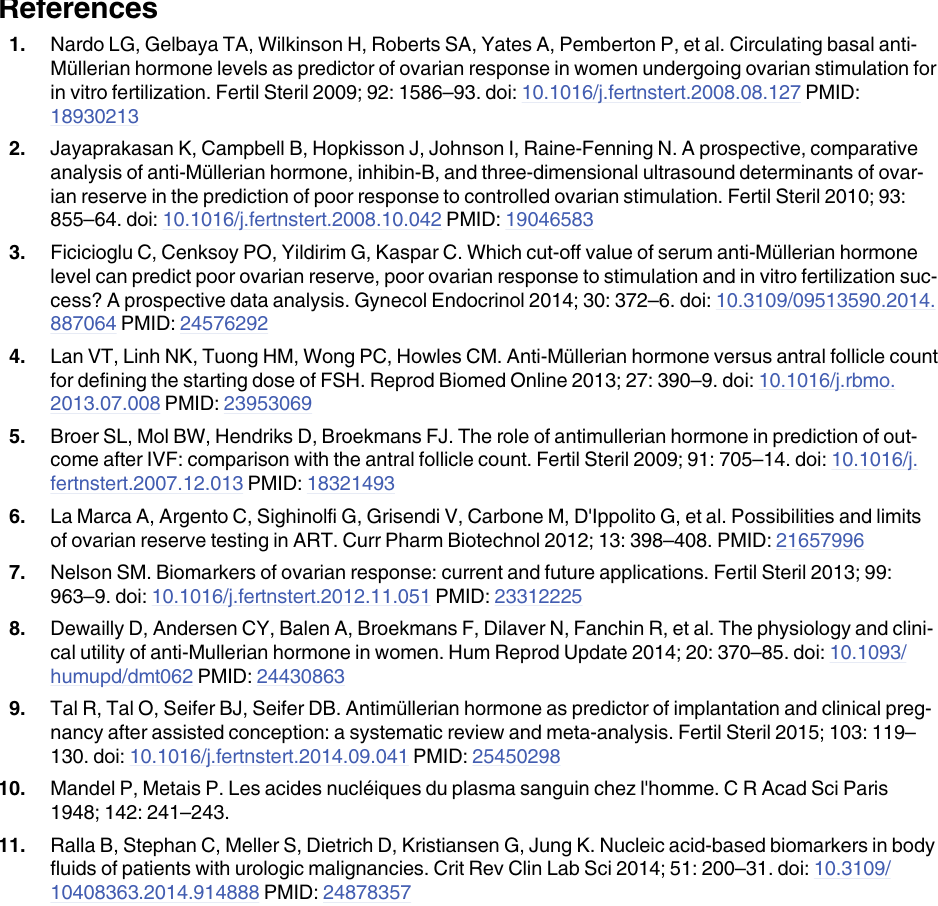
S3 Table. Embryo quality classification at day 2 and day 3 post-fertilization. Embryo quality was graded from 1 to 4 (1 – 2 for top quality embryos; 3 – 4 for poor quality embryos), based on the following morphological criteria: number of blastomeres, blastomere regularity and